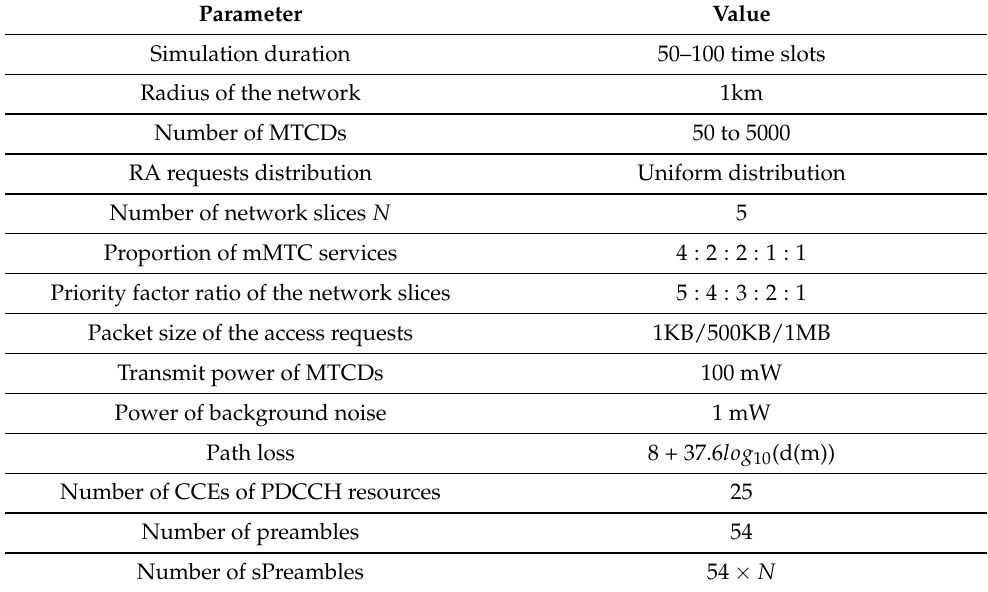
Table 2. Parameters of the